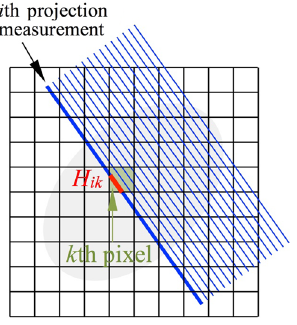
of the ik is calculated as the length of the ik